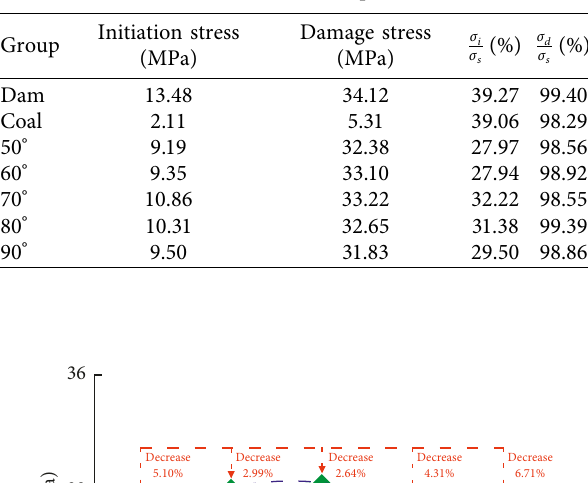
Table 5: Crack evolution of coal pillar-artificial